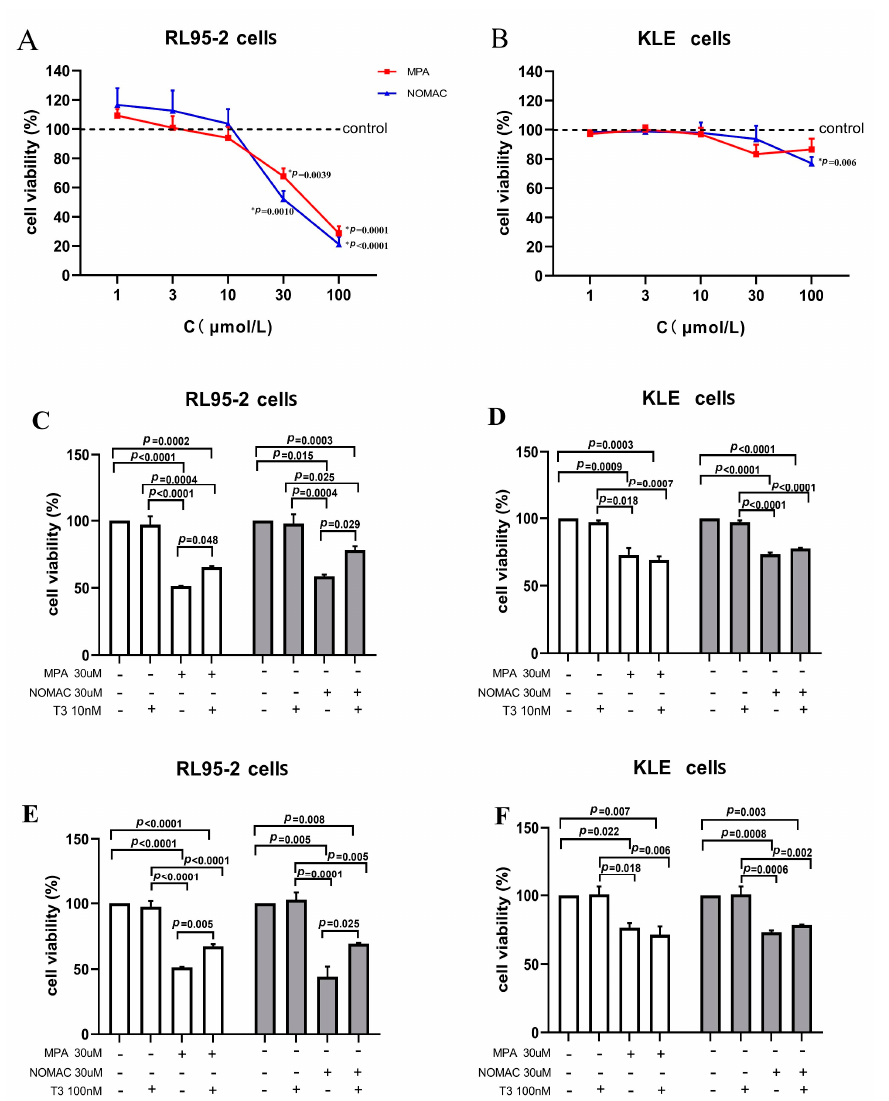
Figure 2. Effects of progestins on the viability of RL95-2 and KLE cells. ( A , B ) Cells were treated with MPA or NOMAc at concentrations of 1, 3, 10, 30, and 100 µ M for 48 h, respectively. ( C – F ) Cells were treated with MPA or NOMAc at a concentration of 30 µ M and their combination with 10 and 100 nM T3 for 48 h. The results are presented as mean ± SEM of wells in triplicate from three independent experiments.